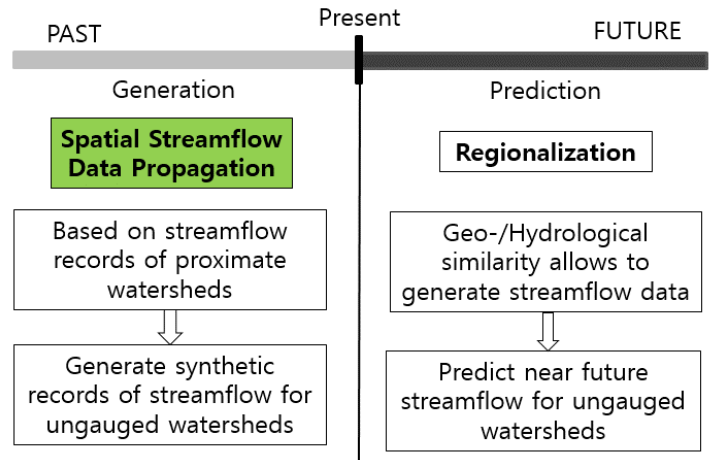
Figure 1. Comparison between the spatial propagation concept and regionalization [15].